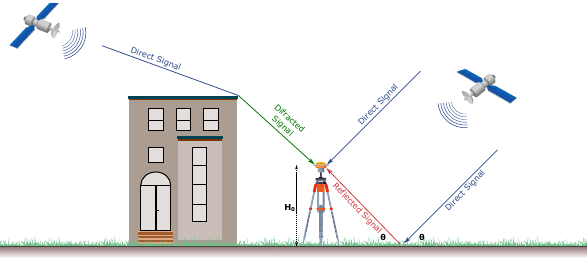
Figure 1. Multipath geometry. The multipath is the interference between the direct and the reflected signal shown in the idealized horizontal surface. H is the height of the GNSS